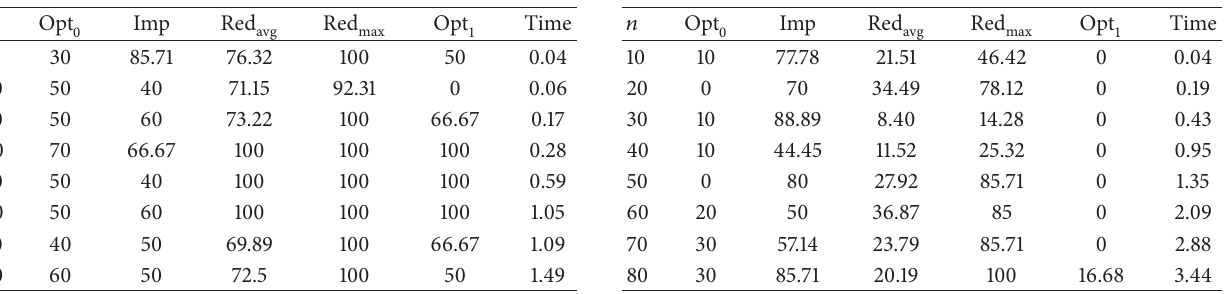
Table 10: Performance of the lower bounds for m = 4.